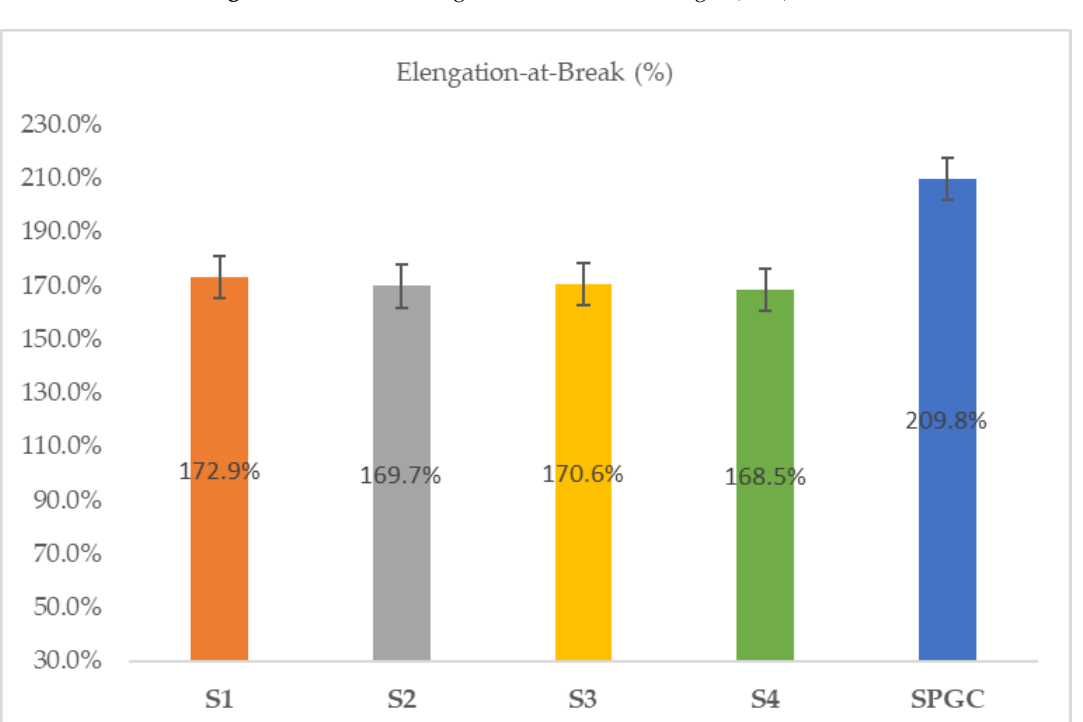
Figure 9. Wound dressings’ ultimate tensile strength (UTS).